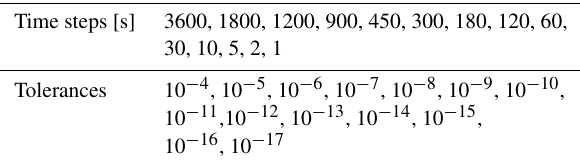
Table A1. Time steps and tolerances used in establishing reference